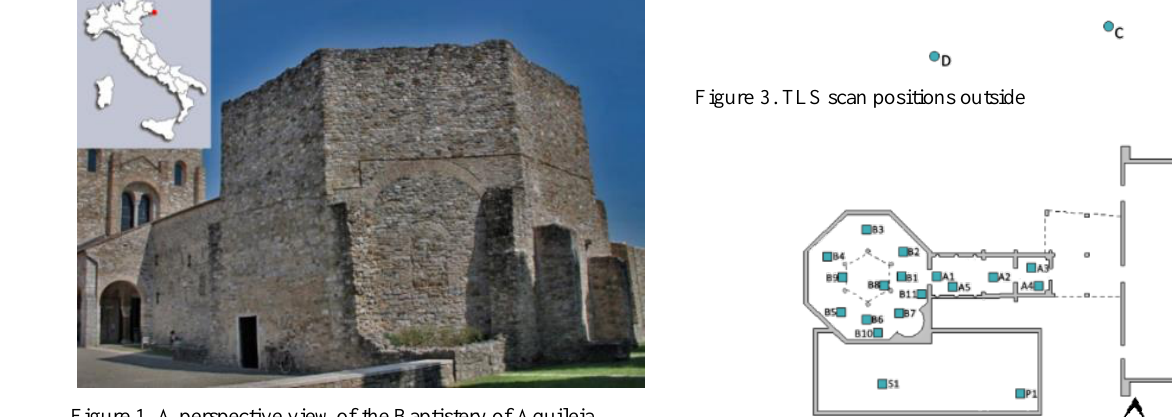
Figure 1. A perspective view of the Baptistery of Aquileia